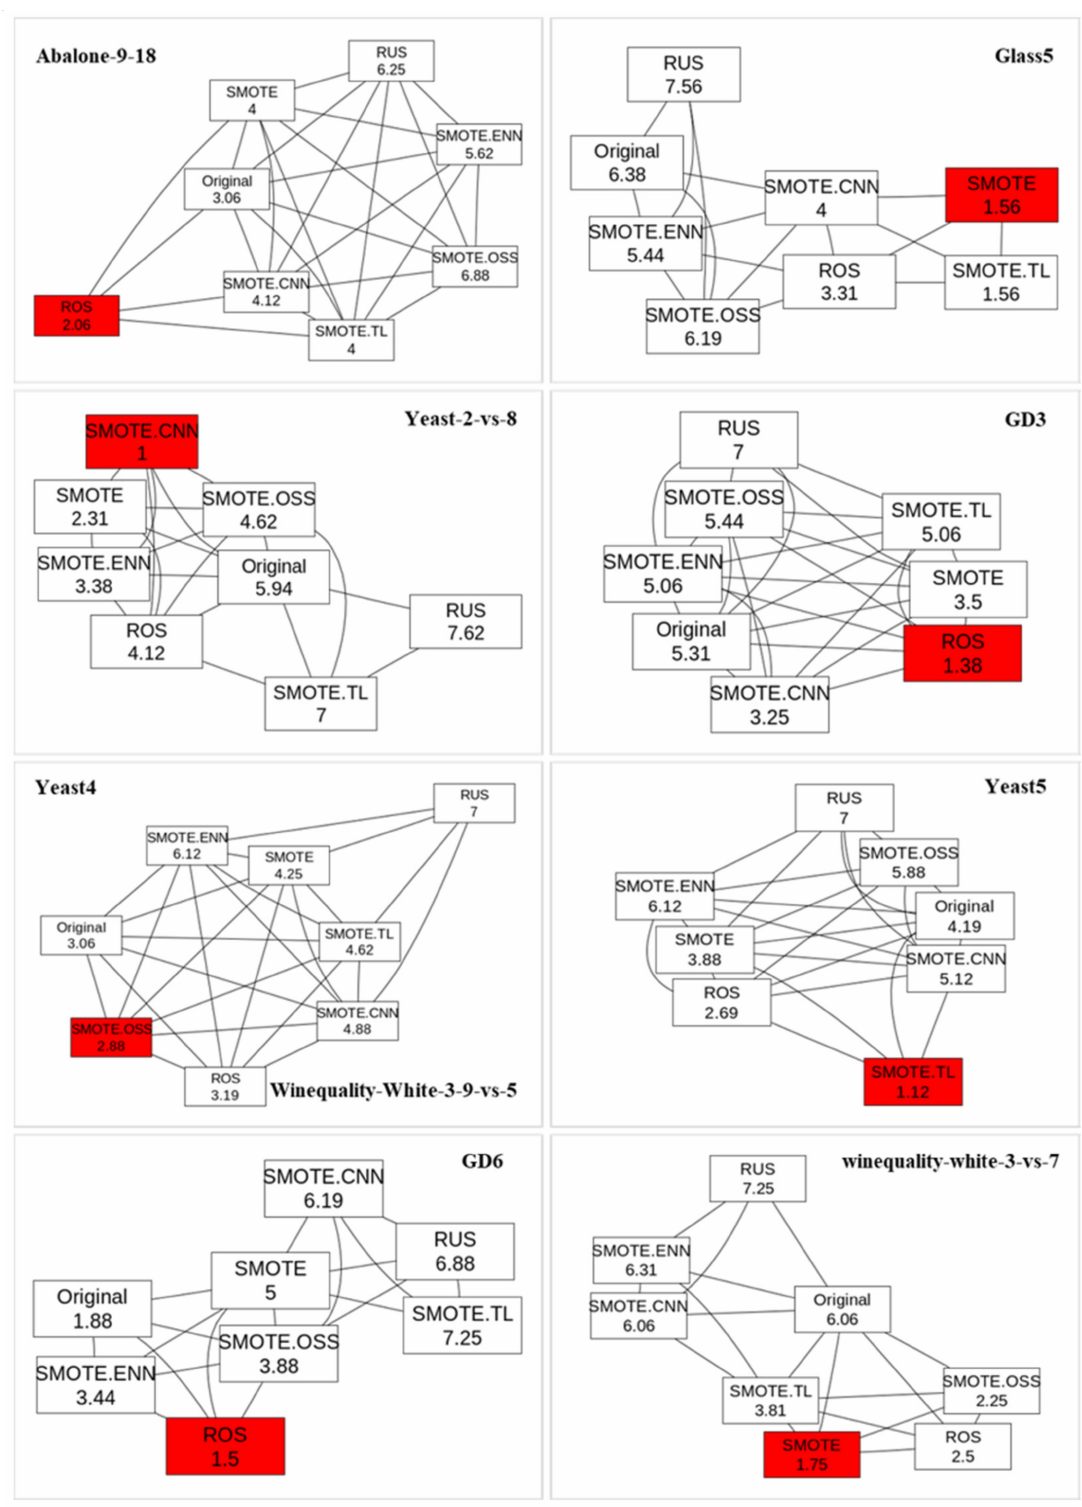
Figure 9. Graphs of the significance test results for some